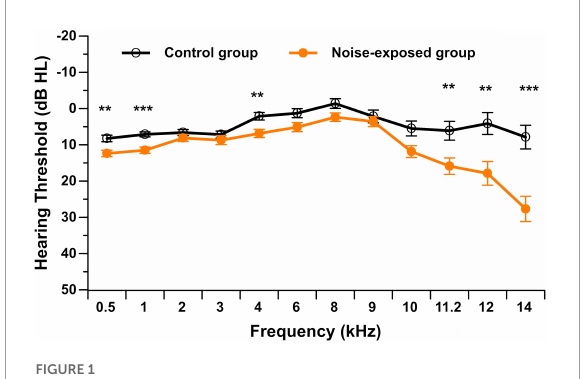
FIGURE2 DPOAE amplitudes (in dB SNR) in the better ear from 2 to 10 kHz in noise-exposed and control group participants. Error bars represent the standard error. No significant differences between groups are observed after Bonferroni correction for multiple